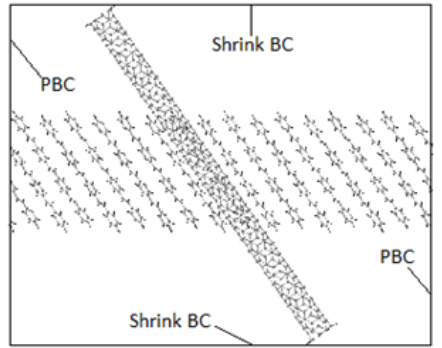
Figure 17. Initial configuration of 4PPV–7 nm × 7 nm graphene interaction.